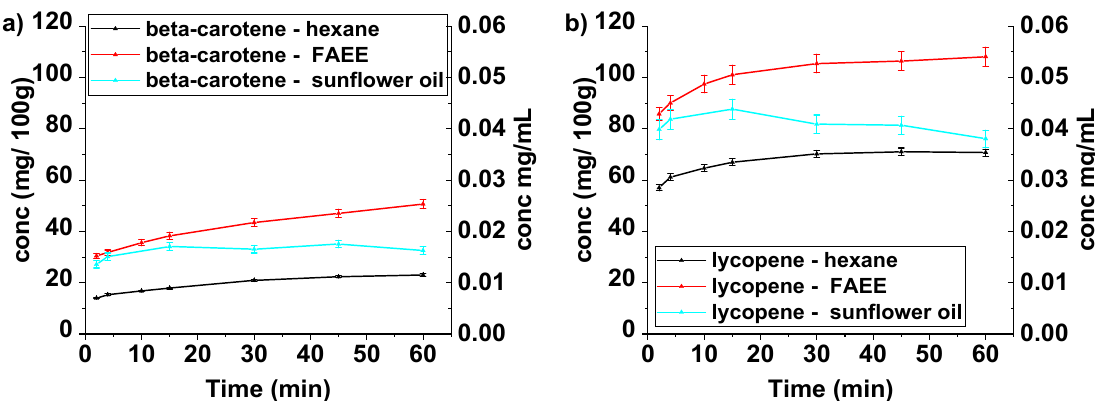
Figure 4. Beta-carotene ( a ) and lycopene ( b ) concentrations (mg carotenoid/100 g dry plant (left y-axis) and mg carote- noid/mL solvent (right y-axis)) during extraction experiments from Pontica 102 skins in different solvents, under conven- tional conditions at 60 °C .